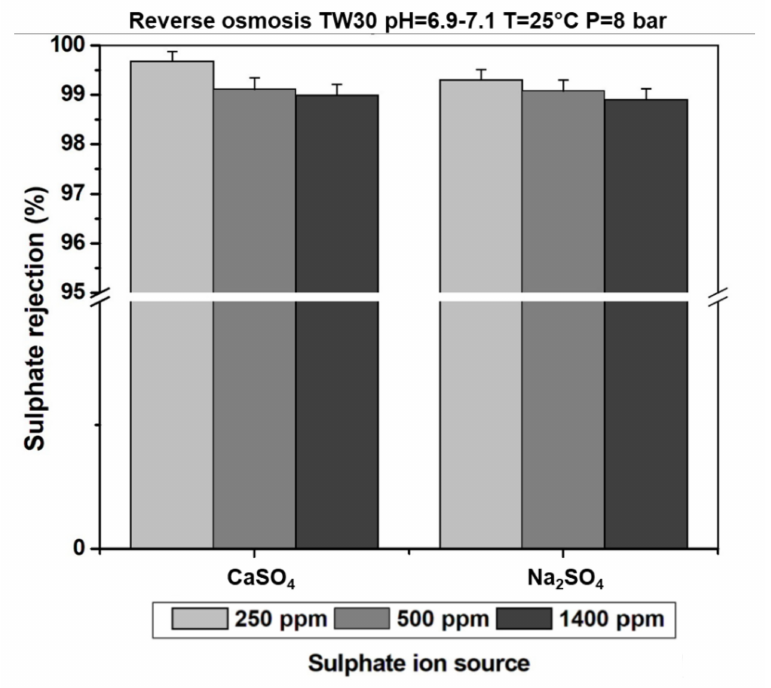
Figure 5. Effect of the sulphate ion concentration in feeding solutions on the rejection rate with the reverse osmosis TW30